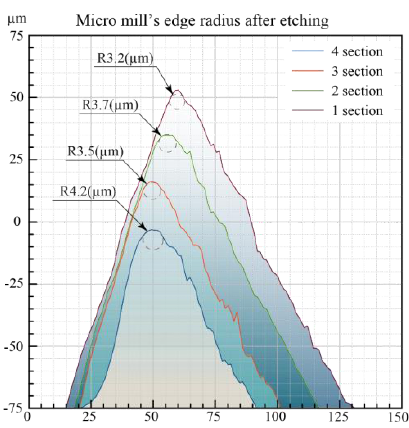
Figure 9. Profiles of the cutting edge radii after etching in four sections distanced from the mill end